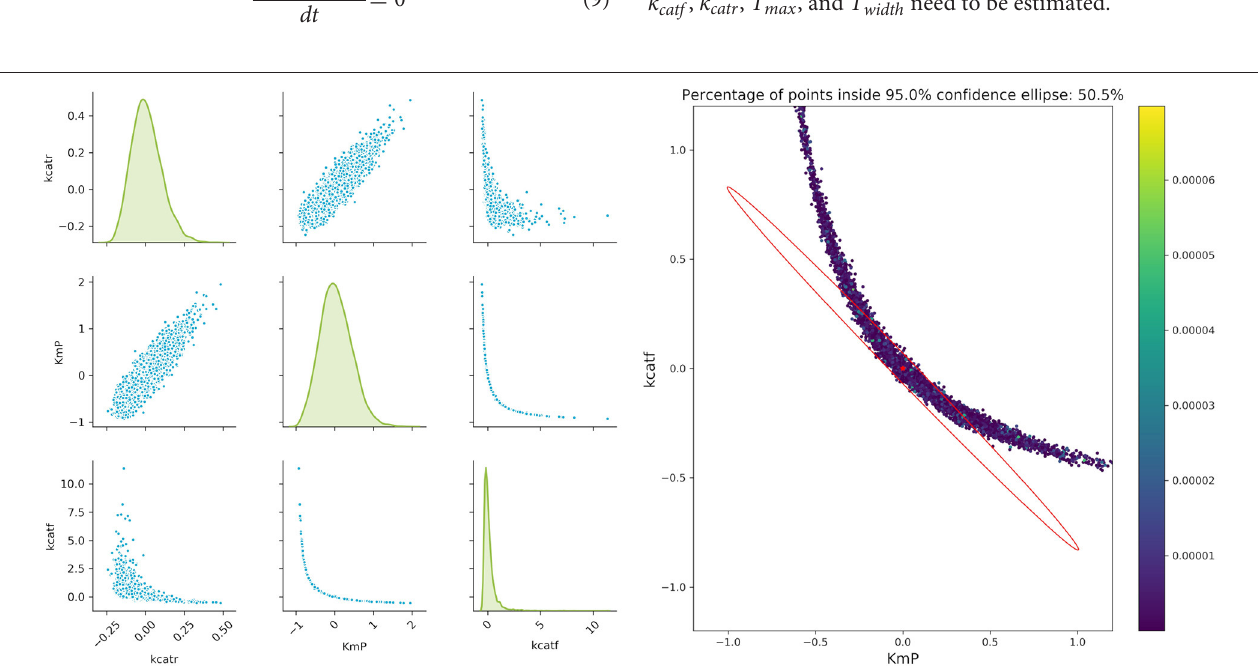
FIGURE 7 | Monte Carlo results for biocatalytic example; Left : pair plots of parameters obtained with data perturbed with Gaussian distributed noise using µ = 0 and σ 2 = 9*10 − 6 ; Right MC vs. FIM for one example, indicating the non-linearities of the parameter estimation.